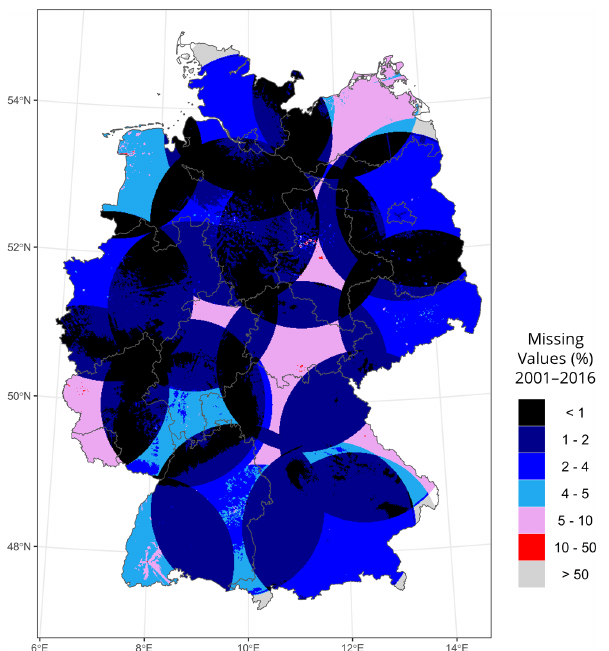
Figure 2. Spatial distribution of the proportion of NaNs (in %) for each pixel of the QPE RADKLIM-YW from 2001–2016. The Ger- man boundary is obtained from the GADM Global Administrative Database (Hijmans et al.,